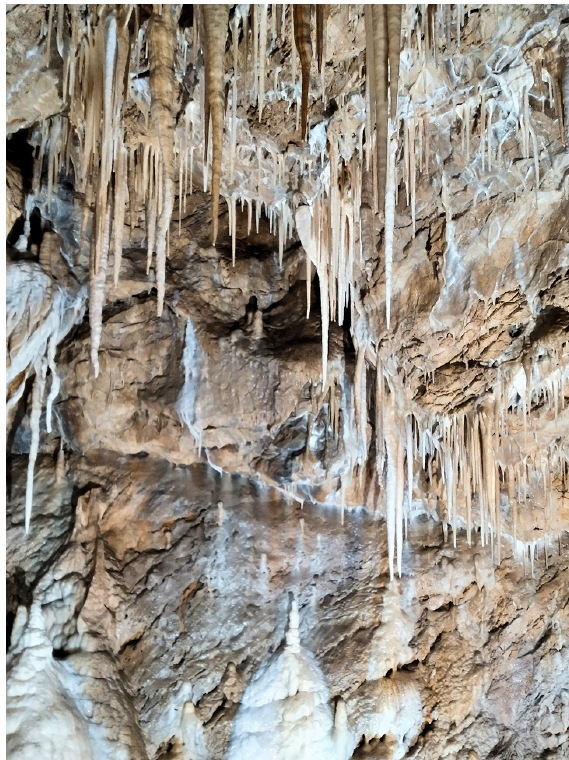
Fig. 8. Speleothems in the Niedźwiedzia Cave, the most attractive show cave in Poland (photo Zb.Zwoliński